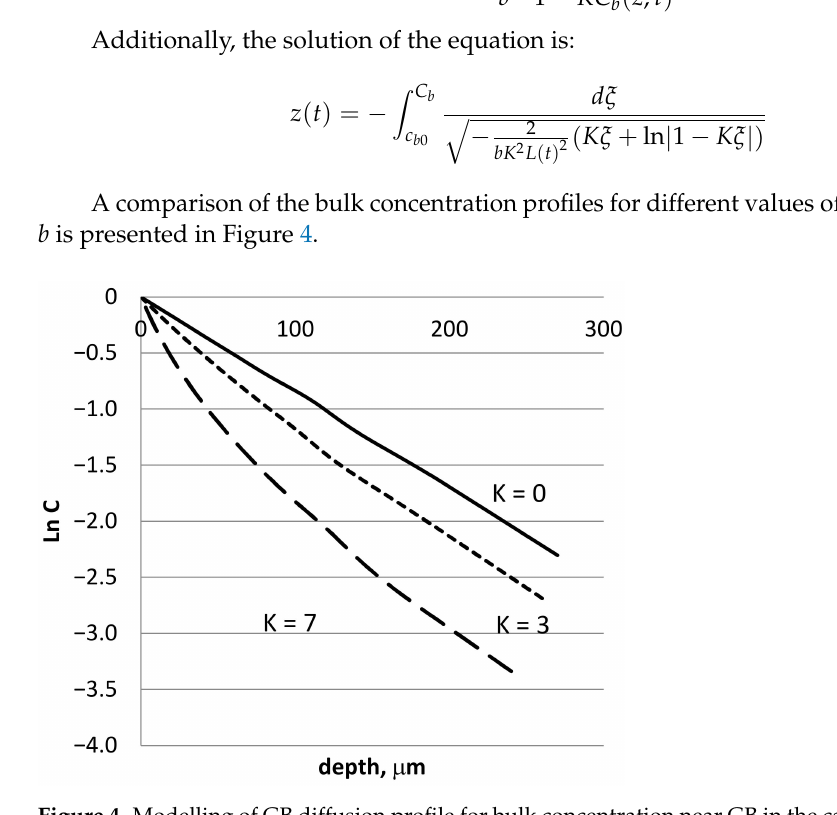
Figure 4. Modelling of GB diffusion profile for bulk concentration near GB in the case of A 2 B complex formation. Diffusion parameters correspond to Zn diffusion in Al at 350 ◦ C, and b =